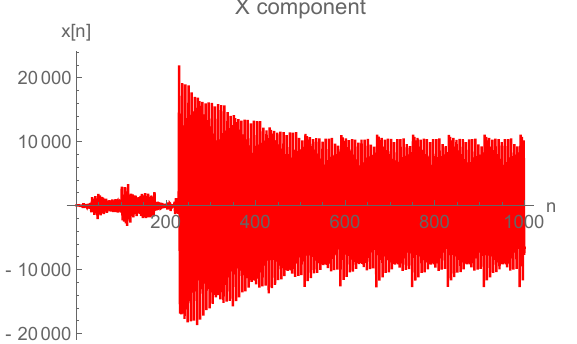
Figure 7. Combined attractor of x n y n (shown in blue line) y n z n (shown in red line) and z n x n (shown in green line) for α = 167, β = 0.01, γ = 0.03, δ = 0.4, ζ = 155, η = 0.05, µ = 0.05, ε = 0.3, υ = 144, ρ = 0.03, σ = 0.08, ω = 0.2. with initial conditions x 0 = 10.0, y 0 = 20.0 and z 0 = 25.0.